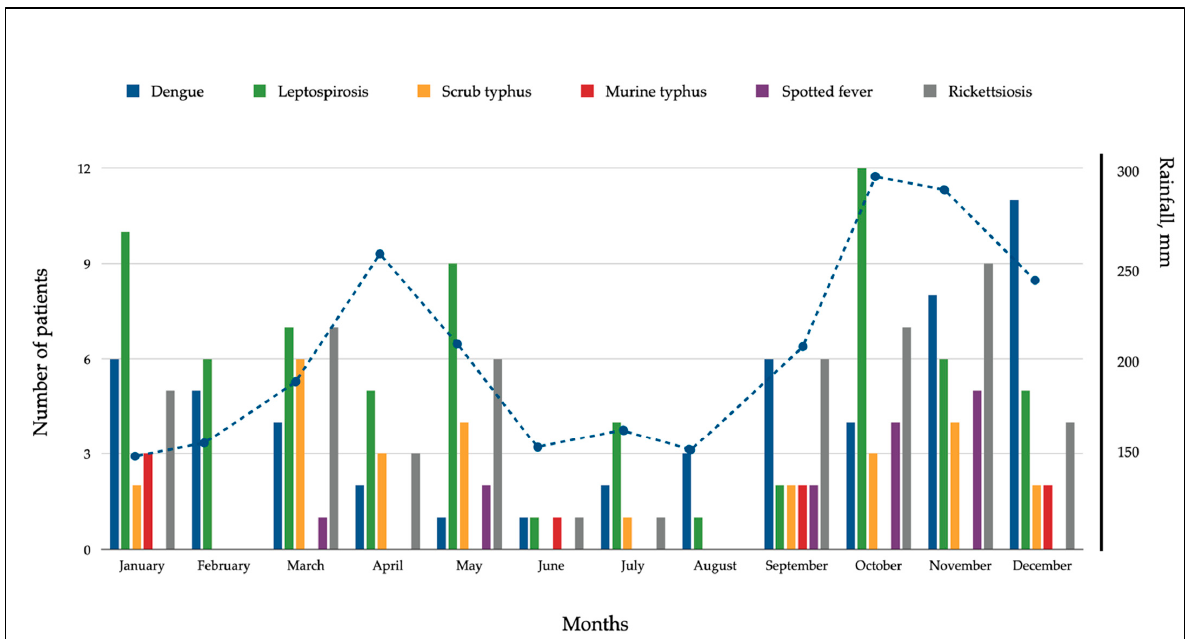
Figure 3. Seasonality of causes of AFI in patients admitted to Teluk Intan Hospital, Malaysia, from January 2016 until December 2016. The dashed line represents monthly rainfall in millimeters. Source: the Malaysia Meteorological Department, Teluk Intan.